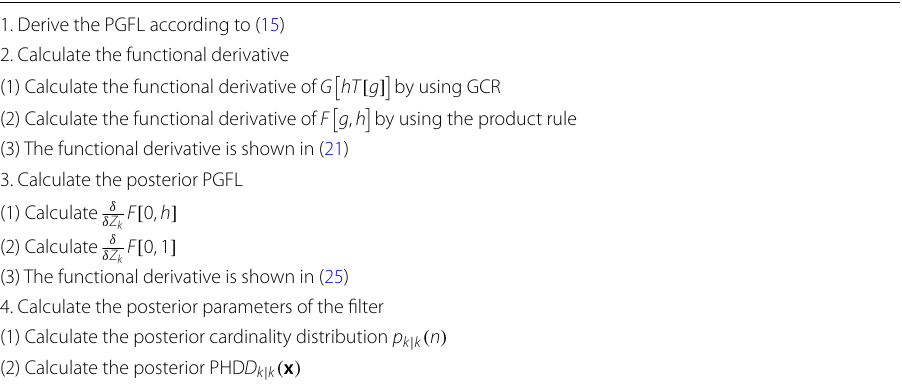
The derivation process of the corrector the general CPHD